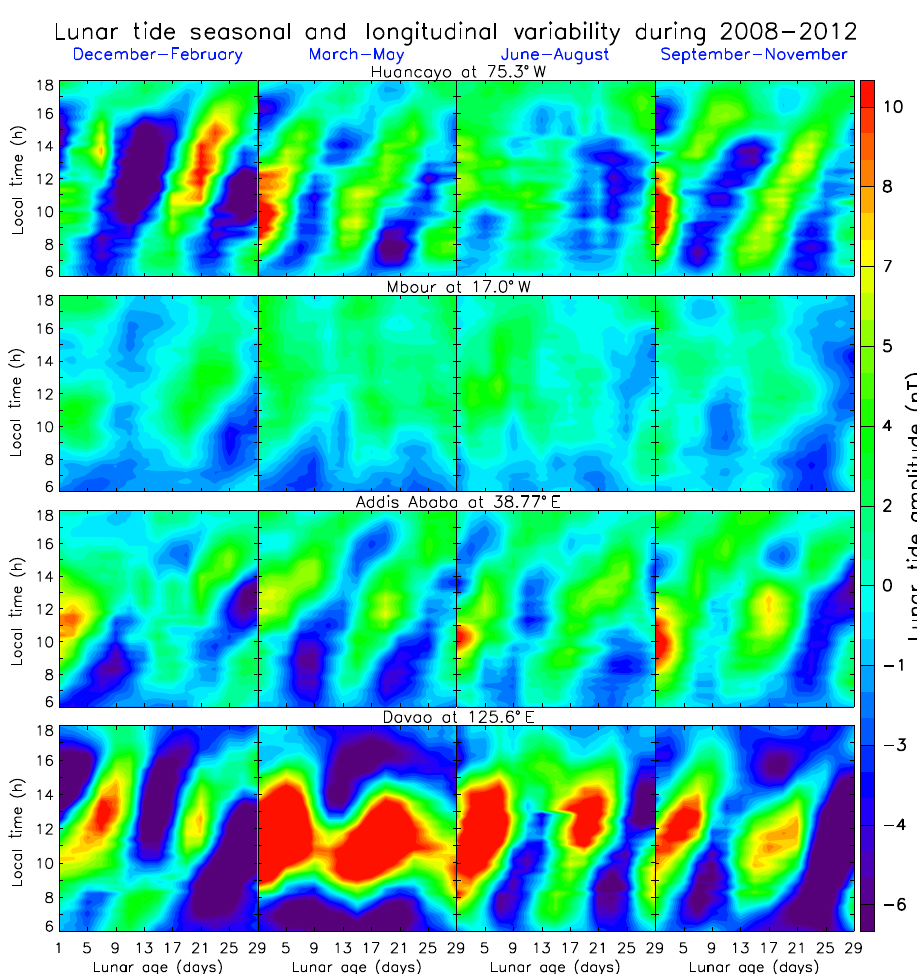
Figure 3. The lunar tide signature on the EEJ detected at different longitudes and seasons. Each panel (from top to bottom) represents different longitudes, as well as (from left right) different seasons. The station name and the corresponding longitude are provided at the top of each panel; similarly, each season is provided in blue at the